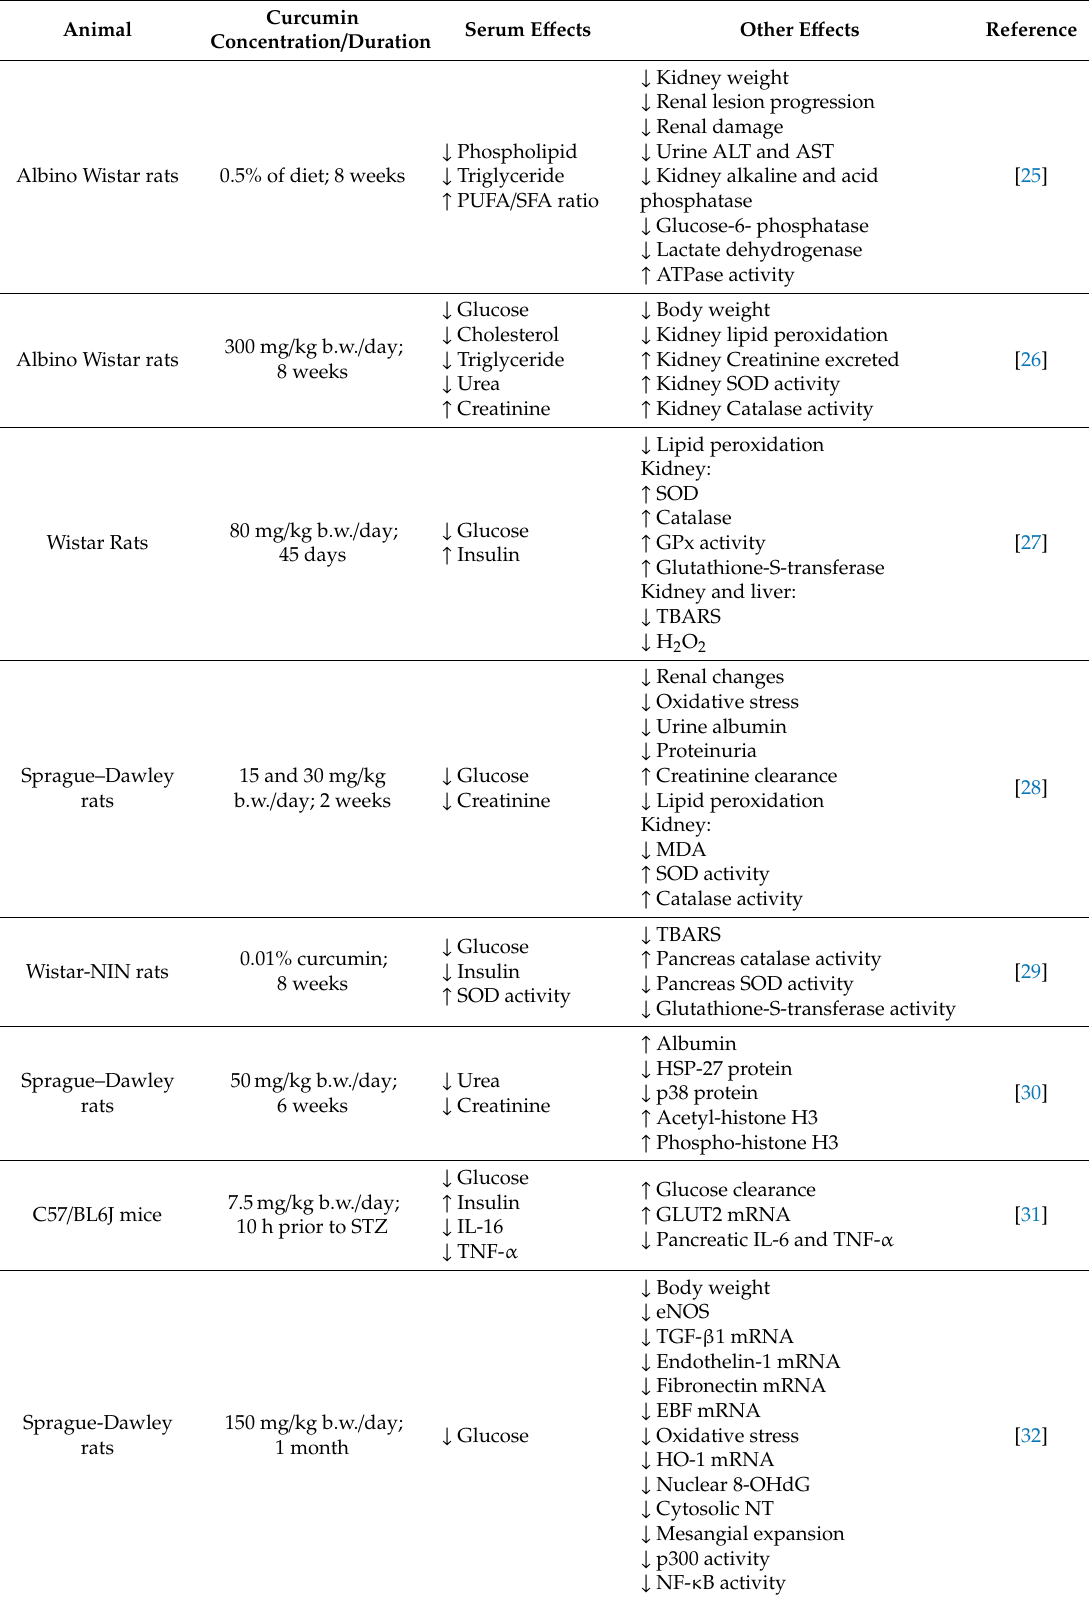
Table 1. Evidence of antidiabetic e ff ects of curcumin: in vivo Streptozotocin (STZ)-induced diabetes animal